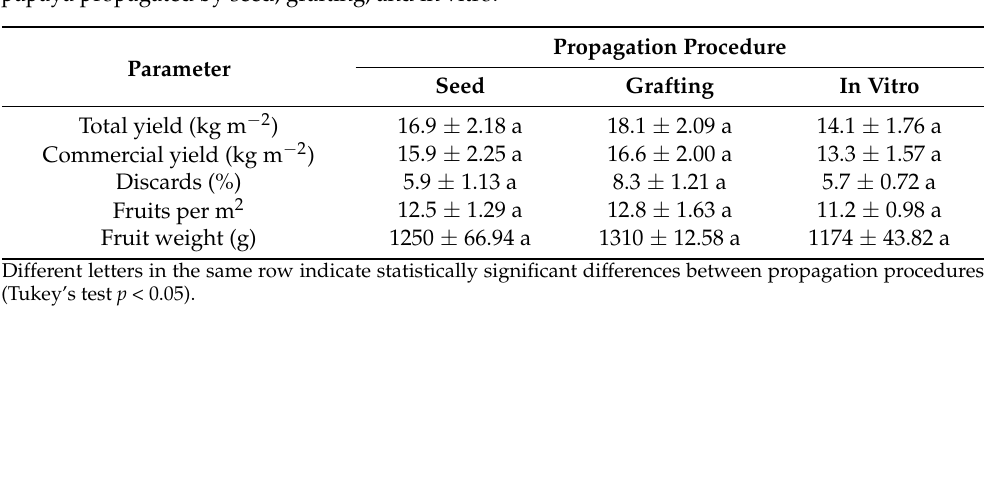
Table 3. Total and commercial yield, discards, fruits number, and weight (average ± s.e.) in ‘Alicia’ papaya propagated by seed, grafting, and in